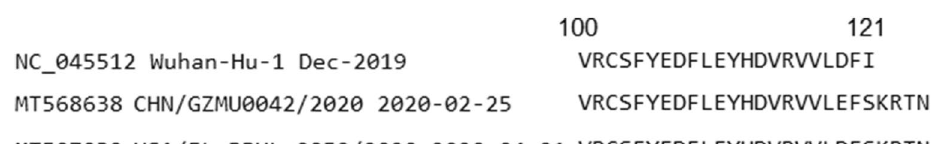
Figure 8. Alignment of protein ORF8 sequences having insertions with the GenBank accession numbers, isolate names and collected dates presented on the left. There is a high chance that the isolate CHN/